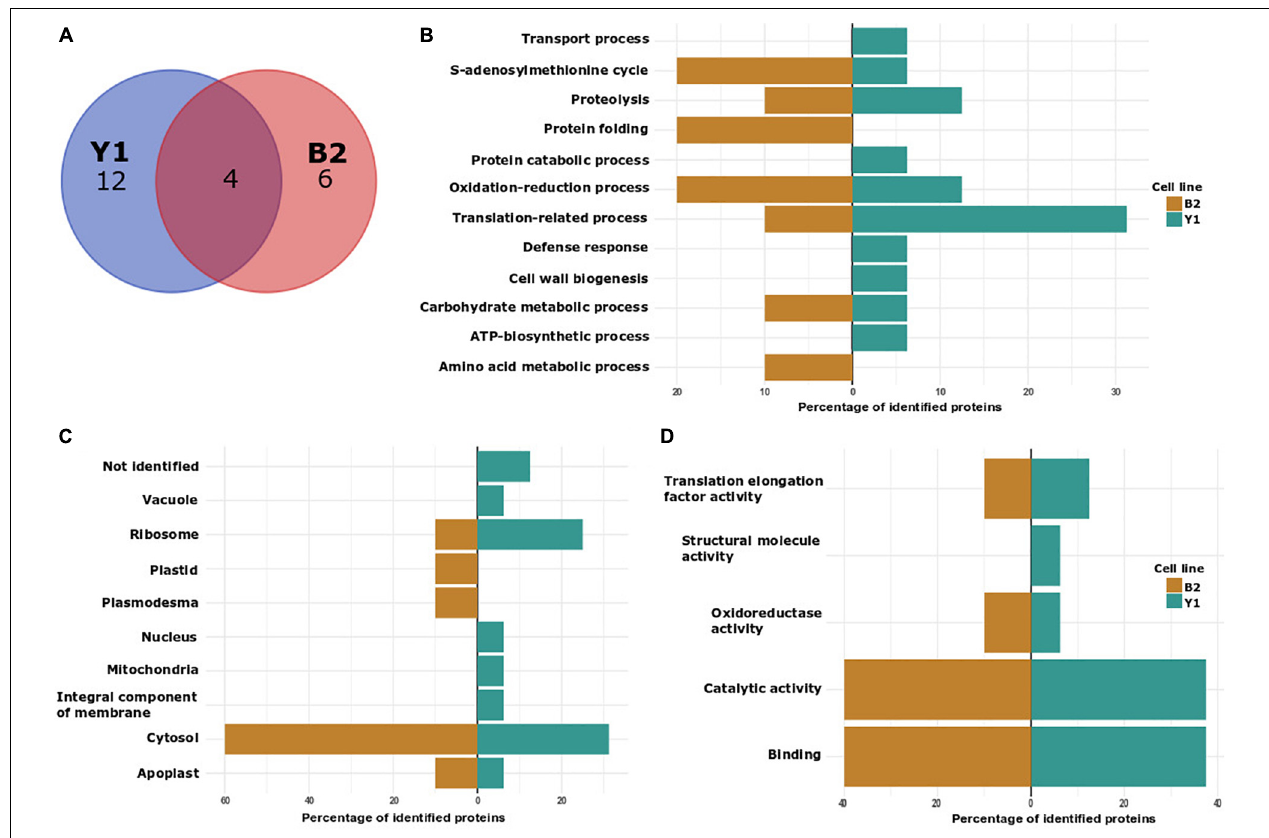
FIGURE 3 | Characterization of in vitro S-nitrosated proteins detected during PEMs proliferation in cell lines Y1 and B2 of Brazilian pine. (A) VENN diagram depicting the number of identified proteins in cell lines Y1 and B2. (B) Biological process classification in GO analysis of proteins detected in cell lines Y1 and B2. (C) Cellular component and (D) molecular